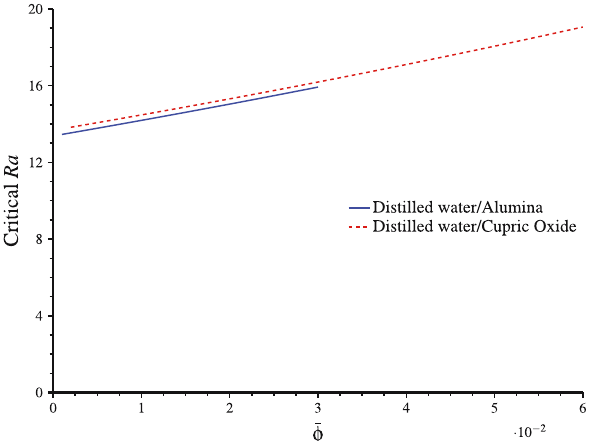
Figure 2: The relation between the volume fraction of nanoparticles and the critical thermal Rayleigh number for a DW/alumina nano fl uid and DW/cupric oxide nano fl uid based on the model of Brinkman and Hamilton - Crosser.